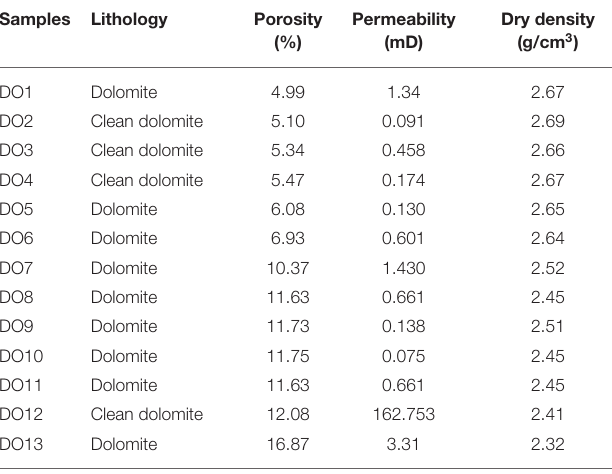
TABLE 2 | Rock properties for carbonates. Samples Lithology